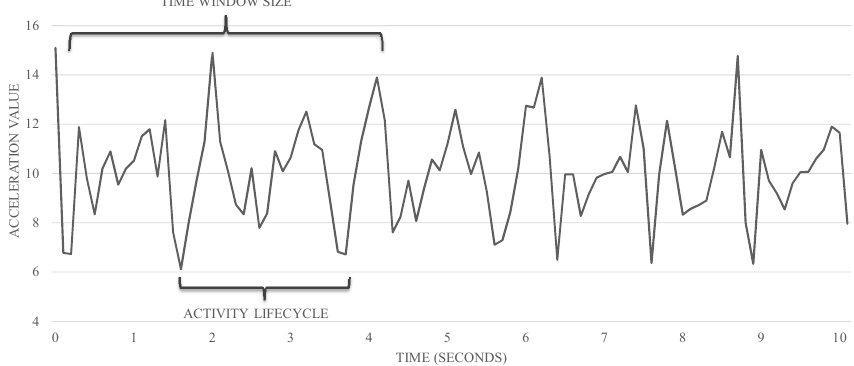
Figure 3. Relation between windows length and activity